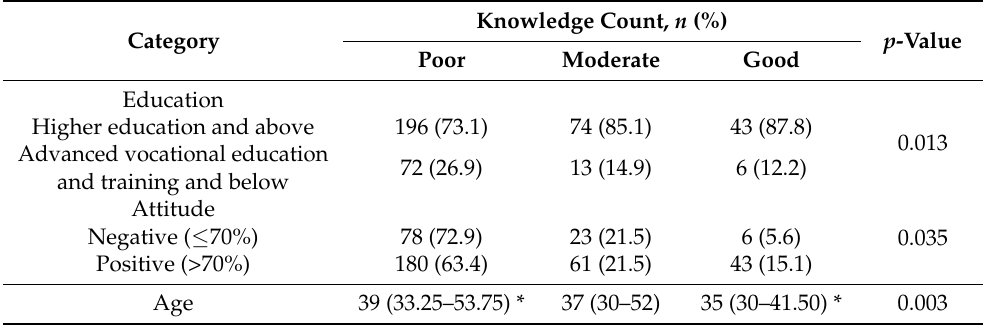
Table 4. Descriptive and statistical interference related to age, education, and attitude.